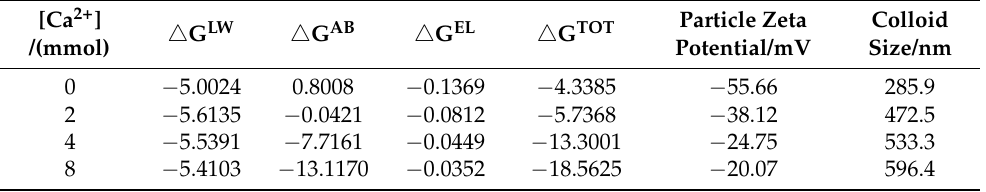
Table 2. Interaction energy, particle zeta potential, and colloid size indifferent AEM-HA-Ca 2+